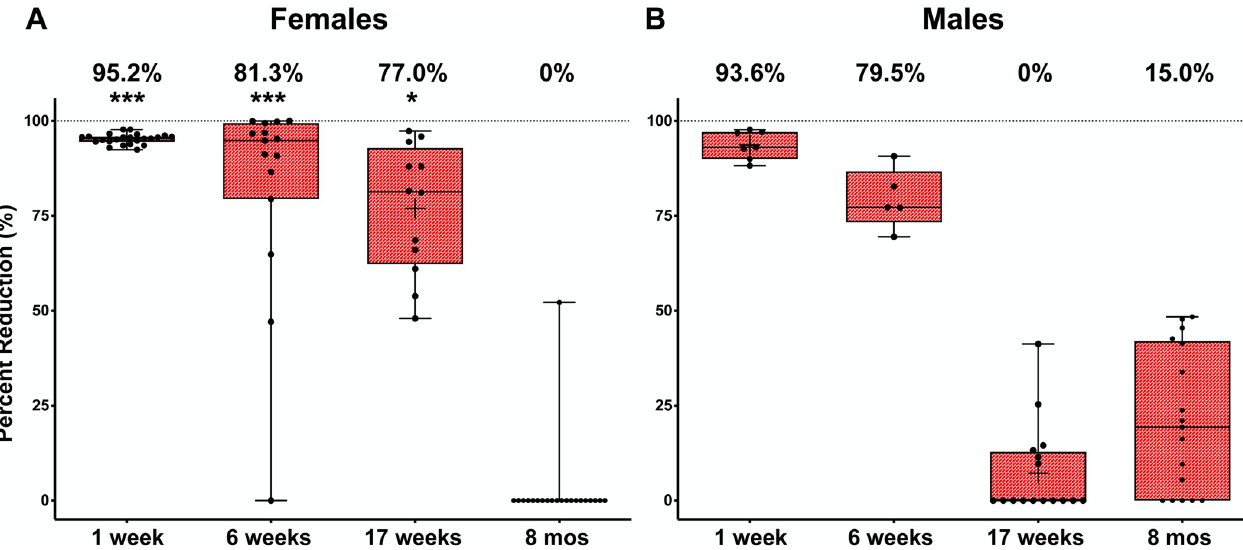
Fig 1. Wolbachia titers return to control levels 8 months after rifampicin treatment. Female and male Brugia pahangi from jirds treated with rifampicin were analyzed by qPCR to determine Wolbachia titers at each timepoint. Mean percent reductions of Wolbachia wsp / gst ratios from female (A) and male (B) adult worms are shown at 1-week, 6-weeks, 17-weeks and 8-months post-first dose. Data shown are medians and the boxes are the 25 th and 75 th percentiles with ��� P < 0.001 and � P < 0.05. n = 2–9 jirds per treatment group per timepoint. Additional information is shown in S1 Table.